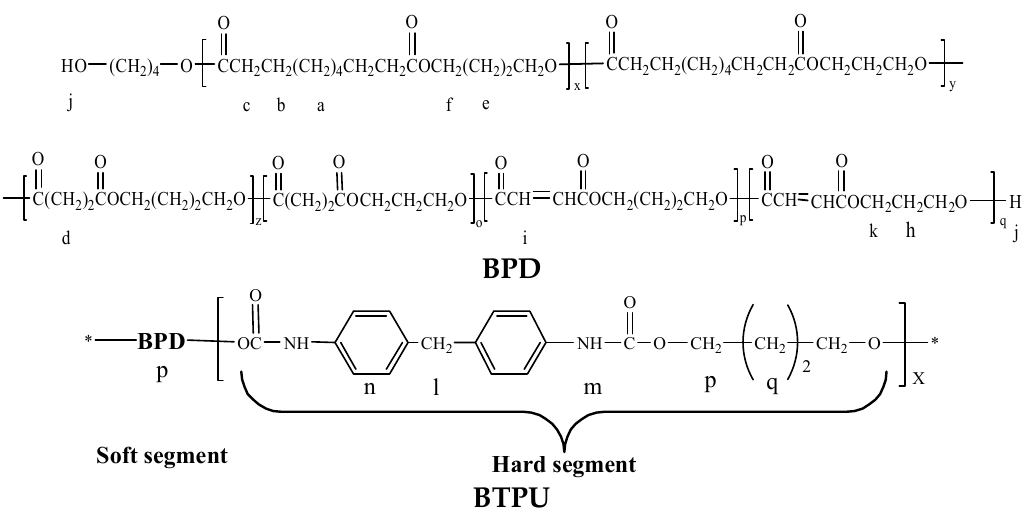
Figure 3. Molecular structural formulas of BPD and BTPU.